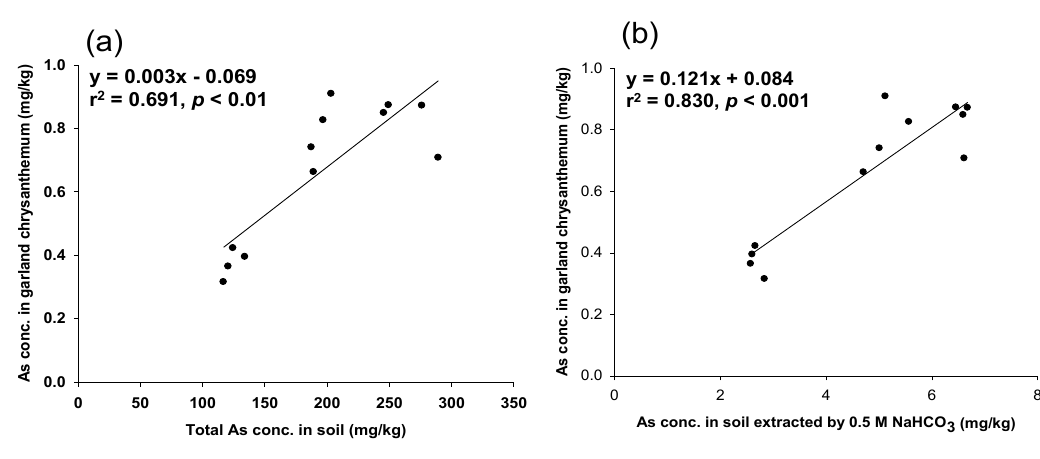
/H O ; ( b ) 0.5 M NaHCO 3 2 2